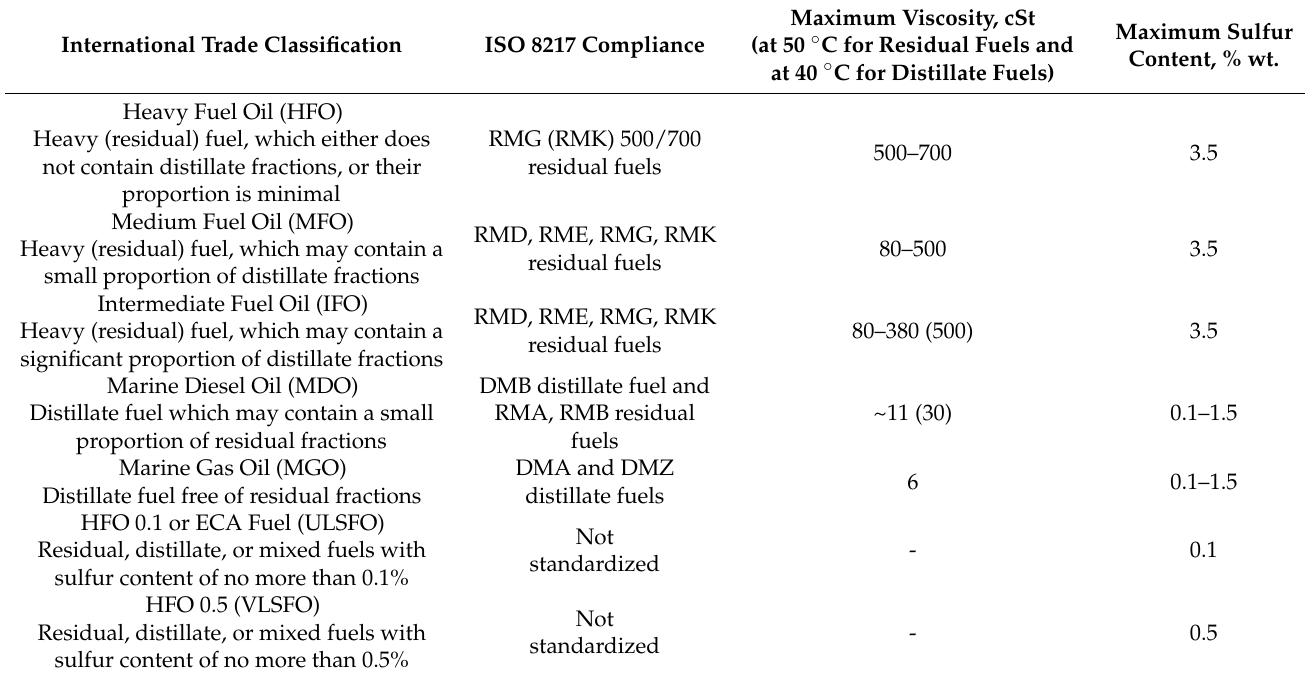
Table 1. The exchange (trade) classification of marine fuels and ISO 8217 standard compliance